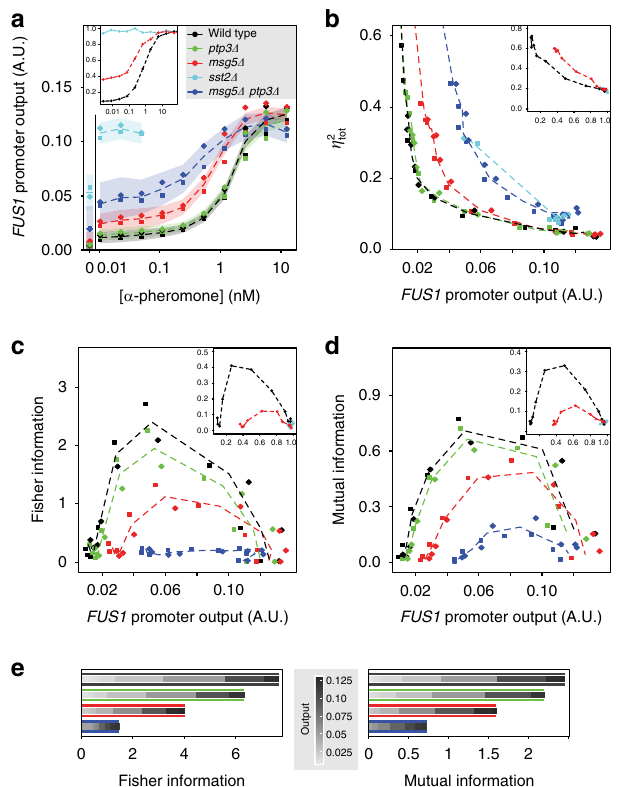
and information transmission. a Dose dependence of pathway activation, measured using activity of a P FUS1 - GFP pathway reporter, for wild type (black) and strains deleted for negative regulators (colours as indicated). Data were collected between 140 and 210 min after pheromone addition, using time-lapse microscopy (see “ Methods ” ), in two independent experiments (shown with different symbols). Dashed lines connect means for both experiments and serve as a guide to the eye; shaded areas centred on those lines show cell-to-cell variabilities (s.d.) across the cell populations, again averaged over both experiments with at least 300 cells per point and experiment. b Pathway noise, calculated as the coef fi cient of variation of P FUS1 - GFP levels across the population, in the individual experiments (symbols as in a ), plotted against the P FUS1 - GFP output. Dashed lines connect the means of noise and P FUS1 -GFP output for both independent experiments. c , d Fisher ( c ) and mutual ( d ) information, calculated as described in “ Methods ” independently for both experiments (symbols are as in a ). Notably, although mutual information was calculated between the pheromone input and the pathway output, it was plotted against the pathway output at a particular pheromone input for better comparison between strains that have different sensitivities to pheromone. Dashed lines connect means for both independent experiments. Fisher and mutual information are not shown for sst2 Δ strain. Insets in a – d show results of stochastic simulations using a simpli fi ed mathematical model of the pheromone pathway (see main text). e Aggregated, i.e. summed up over the whole output range, Fisher (left) and mutual (right) information, with individual contributions at different output levels shown in different shades of grey. Aggregated information was calculated from means for both independent experiments. Edges of bars are coloured according to the strains as indicated in a